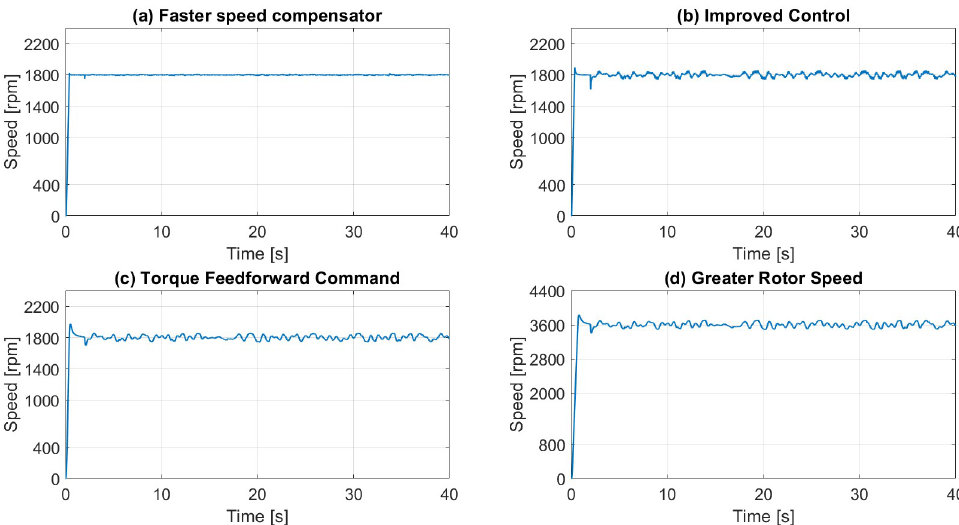
Figure 30. Speed Simulation Results with proposed modifications: ( a ) faster speed compensator;